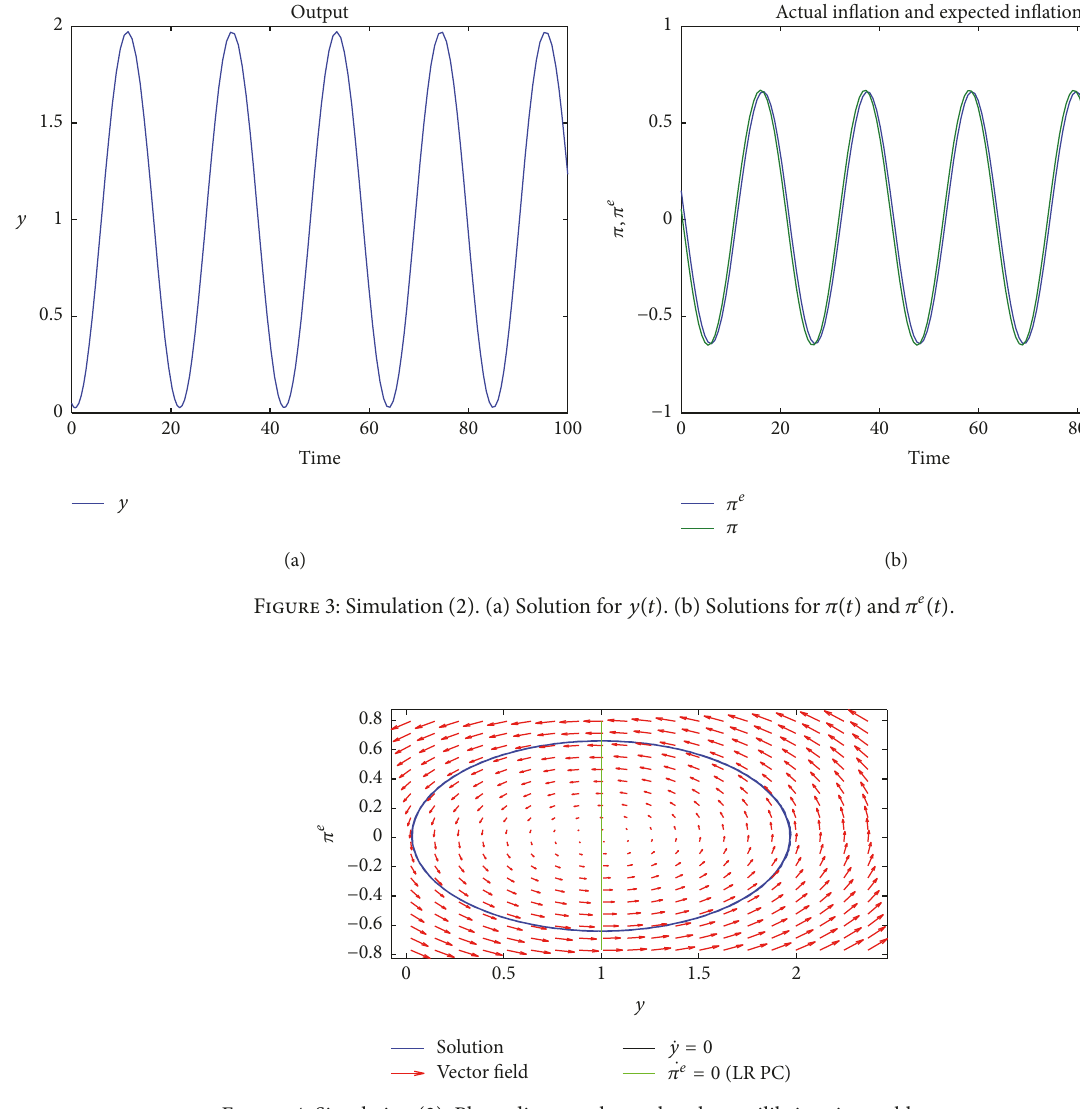
Figure 4: Simulation (2) . Phase diagram shows that the equilibrium is a stable